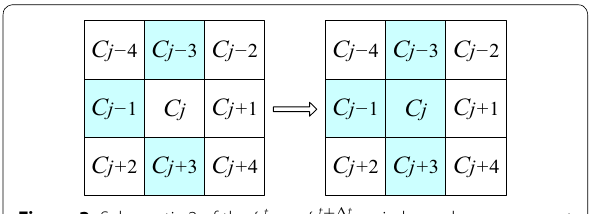
Figure 3 Schematic 2 of the ξ t Cj → ξ t + � t Cj grain boundary movement